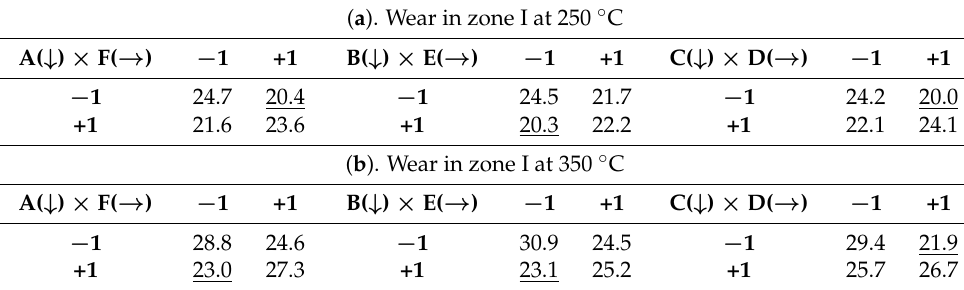
Table 10. Analysis of the interactions AF, BE, and CD.